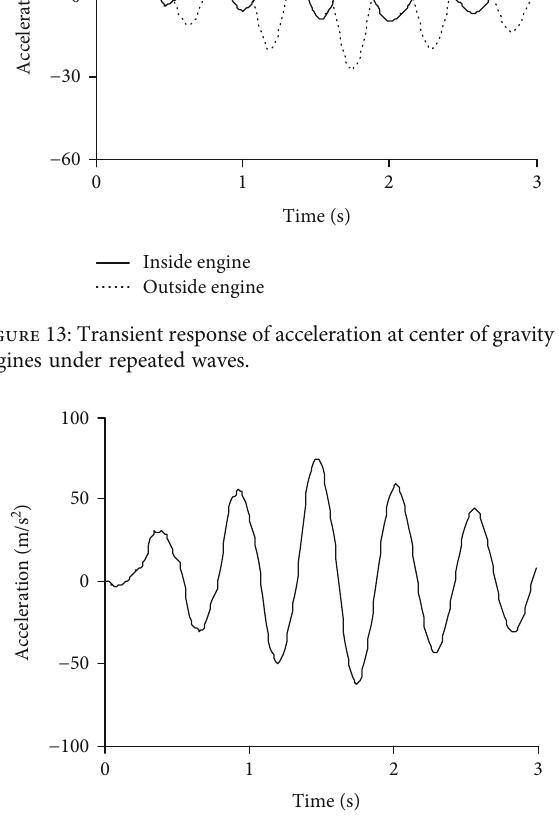
Figure 14: Transient response of acceleration at center of gravity of fl oat under repeated